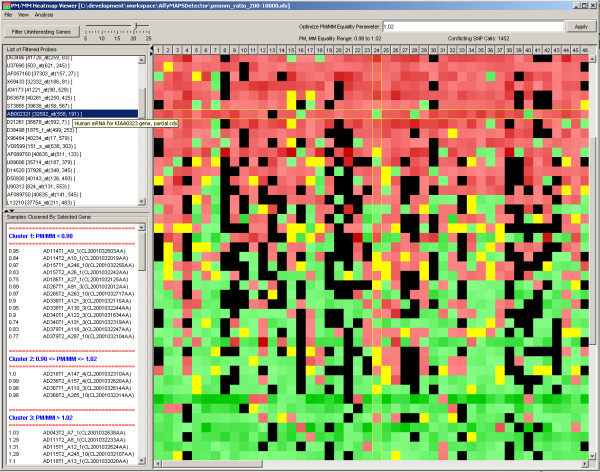
Expression Genotype. An instance of a PM/MM ratio data file from adenocarcinoma positive sample-replicates loaded into the heat-map viewer for expression signature pattern analysis. Removal of unchanging probes from the expression signature pattern and tuning of an equivalency parameter (E) to adjust for measurement precision differences leaves a dataset that can be classed as A [PM/MM < (1.0 - E)], class B [PM/MM > (1.0 + E)] or class A/B [PM/MM between (1.0 ± E) inclusive]. On the right, the table shows the data state as it goes through expression signature pattern steps.